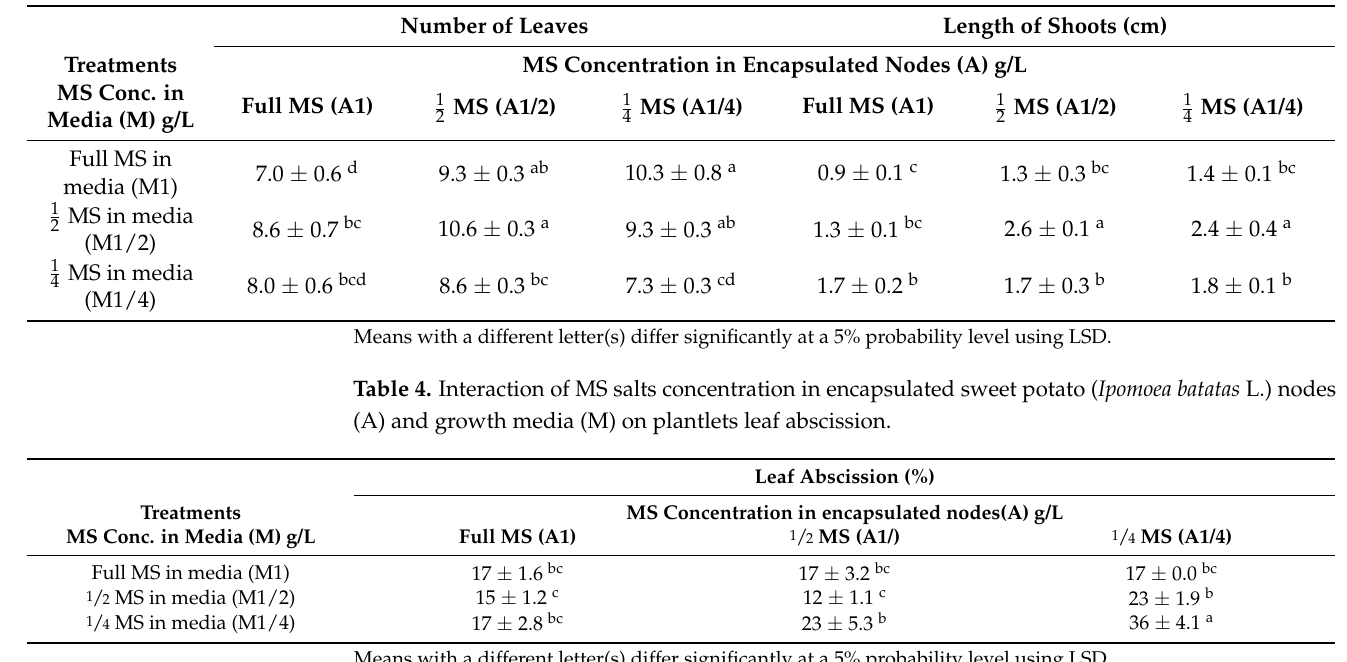
Table 3. Interaction of MS salts concentration in encapsulated sweet potato ( Ipomoea batatas L.) nodes (A) and growth media (M) on number of leaves and shoot length at four weeks after inoculation.